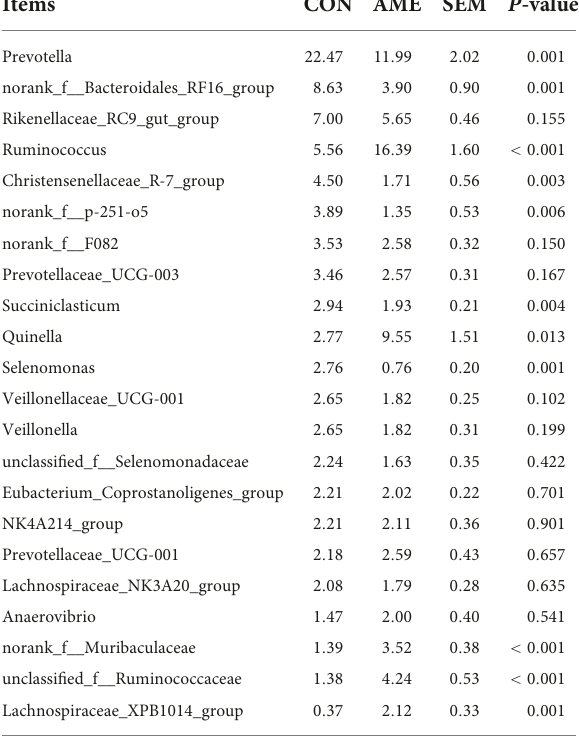
The relationships between BCFA levels, rumen fermentation parameters and the bacterial community are presented in Figure 2 . Iso-butyrate ( P = 0.015, R = − 0.736; P = 0.003, R = − 0.827) and iso-valerate ( P = 0.011, R = − 0.758; P = 0.001, R = − 0.879) levels correlated negatively with the MOA and MNA levels. At the phylum level, the relative abundances of Desulfobacterota ( P = 0.016, R = − 0.733) and Proteobacteria ( P = 0.025, R = − 0.697) correlated negatively with the MOA content. The relative abundances of Desulfobacterota ( P = 0.009, R = − 0.770) and Cyanobacteria ( P = 0.038, R = − 0.661) negatively correlated with the MNA